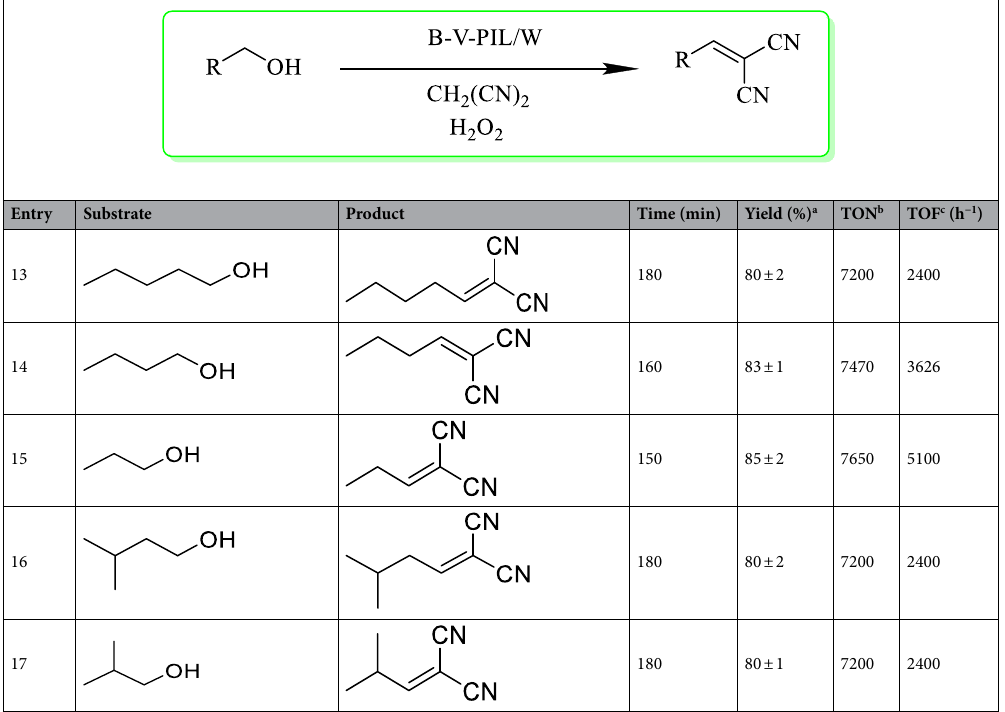
Table 3. One-pot tandem oxidation /Knoevenagel condensation of alcohols with malononitrile catalyzed by B-V-PIL/W. Reaction condition: alcohol (1 mmol), malononitrile (1.2 mmol), H 2 O 2 30% (1 mmol), B-V-PIL/W 40 mg in H 2 O/EtOH (2/1) at 70 °C. a Isolated yield. b TON = mol of knoevenagel product mole of HPA on the catalyst . c TOF = TON Time ( h ) 36,37 .